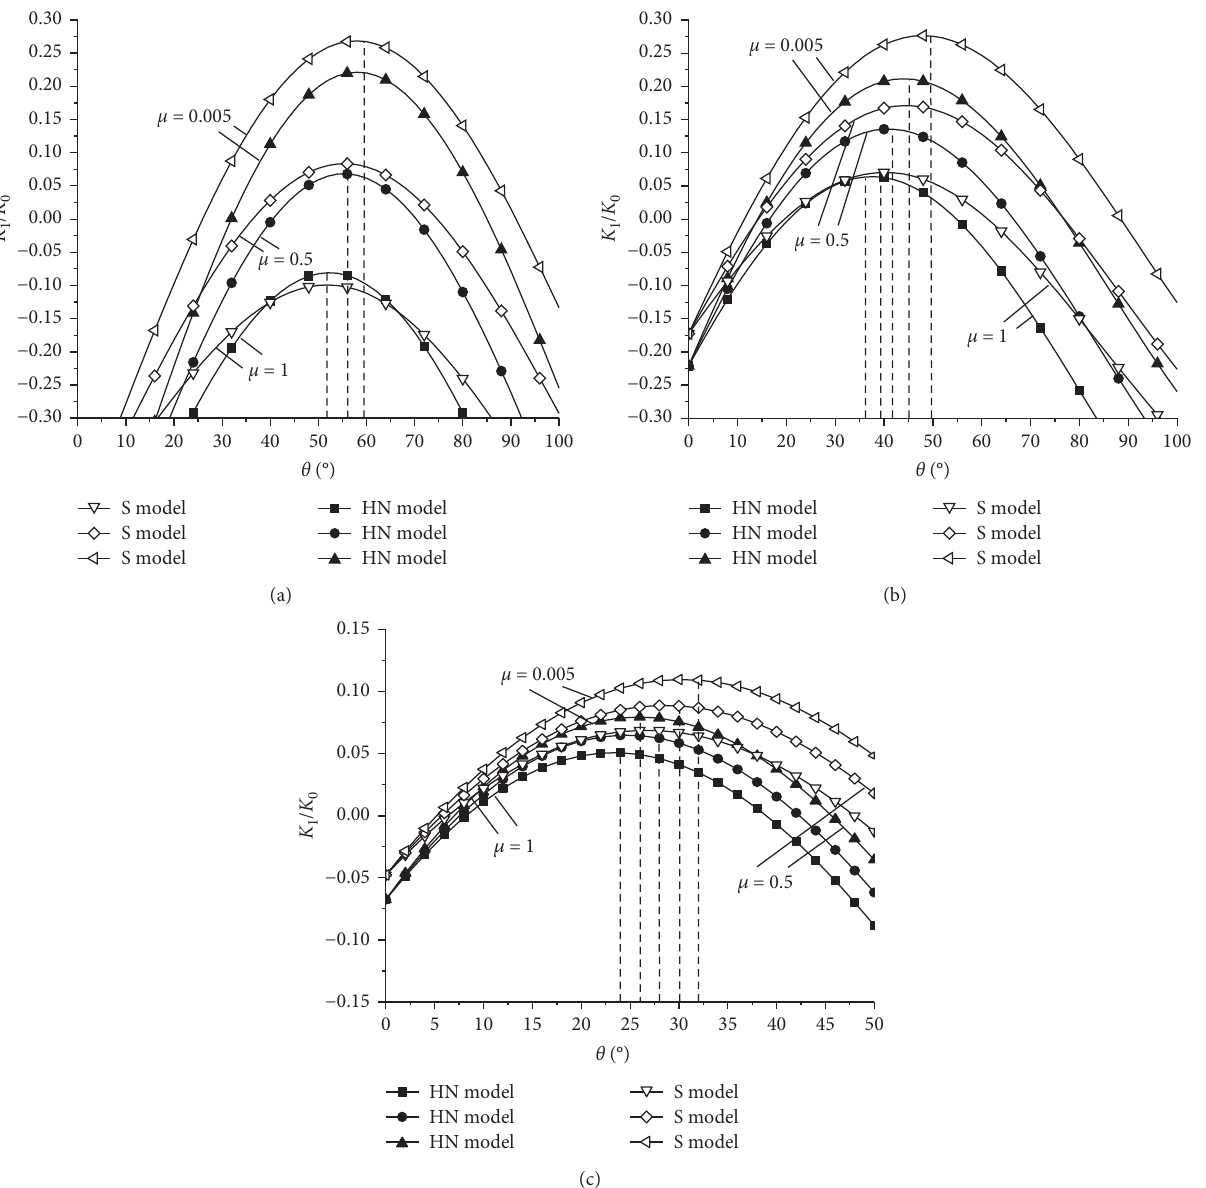
Figure 3: Stress intensity factors computed by different models with different β . (a) β � 36 ° . (b) β � 54 ° . (c) β � 72 °